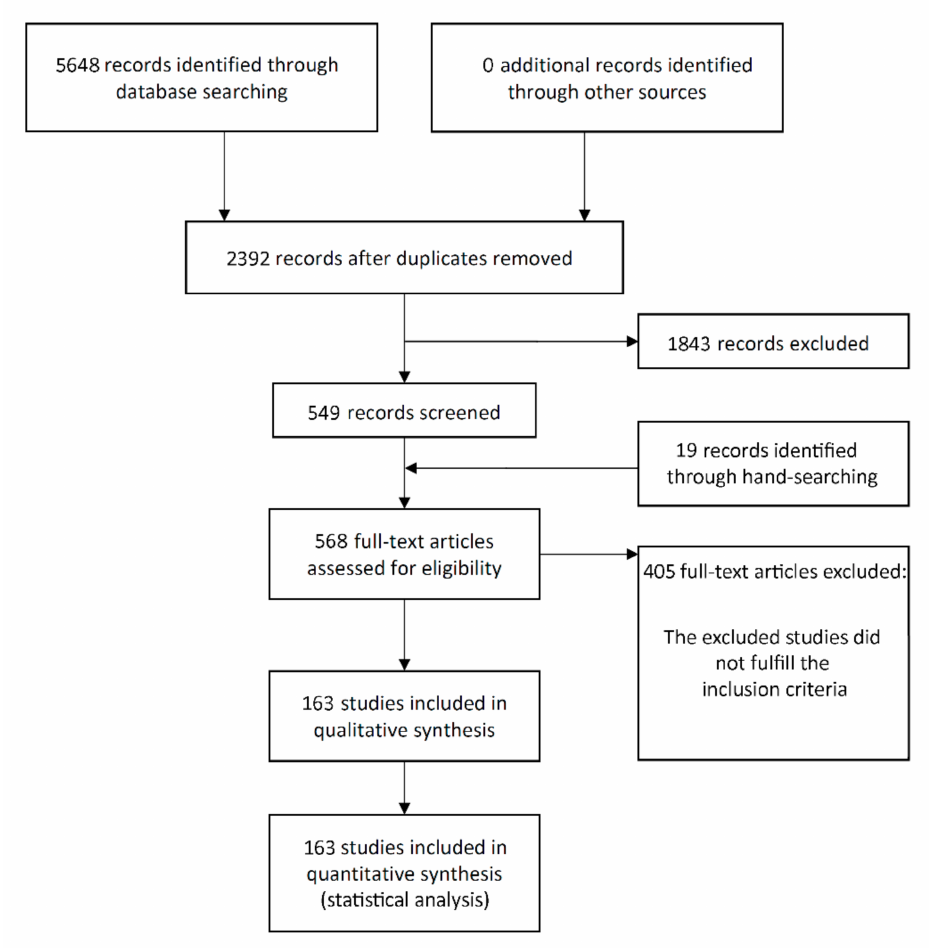
Figure 1. Study screening